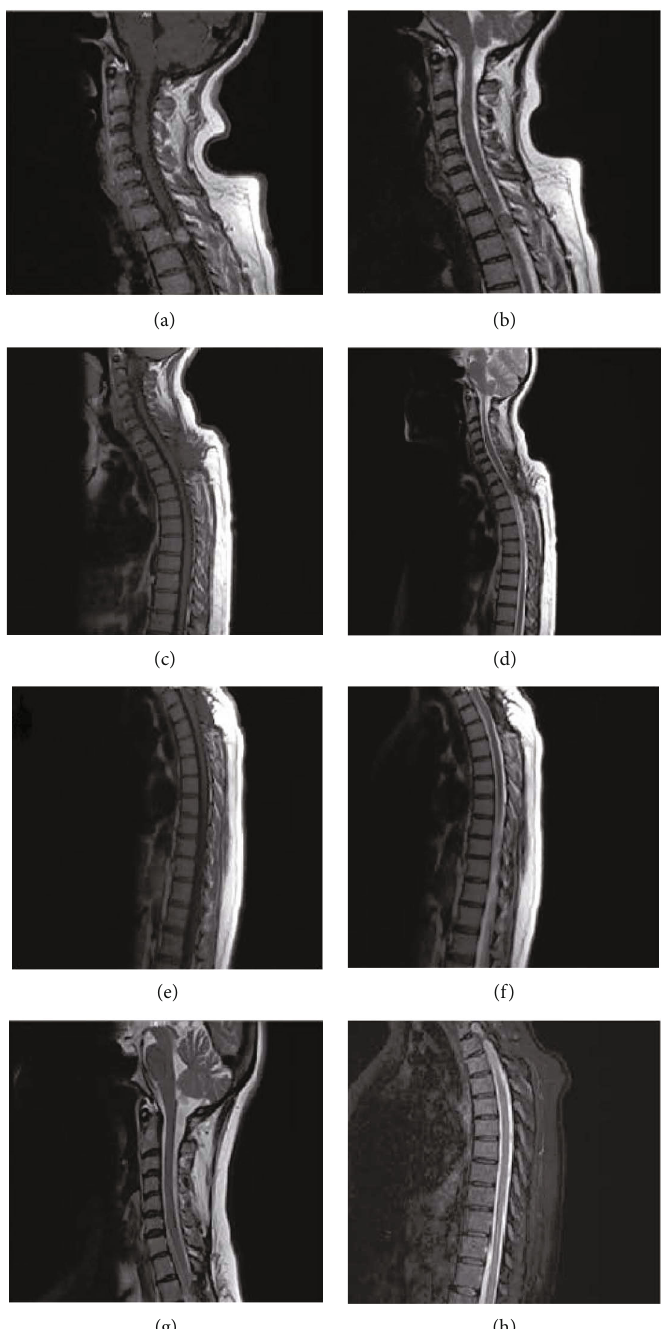
Figure 1: MRI images on preoperative, 3 months postoperative, 1 year postoperative, and current period. (a, b) (08.12.2017) Preoperative MRI reveals a lesion 12 × 10mm in diameter, hypointense in both T1-w and T2-w, heterogeneously contrast enhancing with gadolinium. (c, d) (06.03.2018) Postoperative MRI reveals a paracentral mass located in the posterior edge of the spinal canal with minimal contrast enhancement. (e, f) (19.01.2019) Control MRI reveals. (g, h) (18.02.2021): MRI at current presentation reveals a lesion which is moderately hypointense in T1-w and hypointense in T2-w with homogeneous contrast